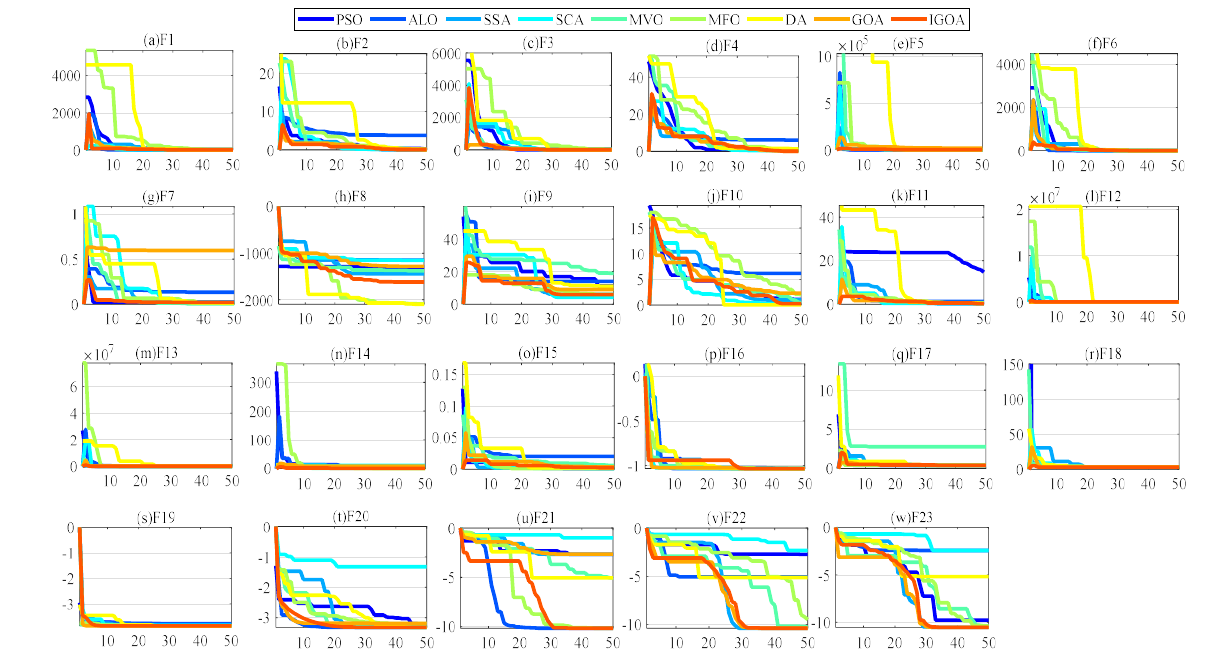
Figure 4. Convergence curves for all algorithms.